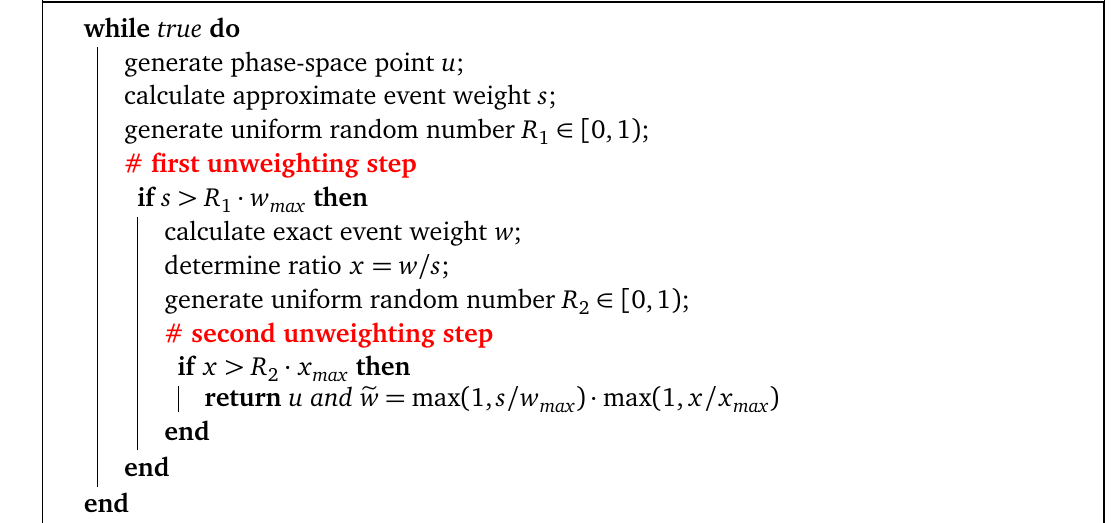
Algorithm 2: Two-stage rejection-sampling unweighting algorithm using an event- wise weight